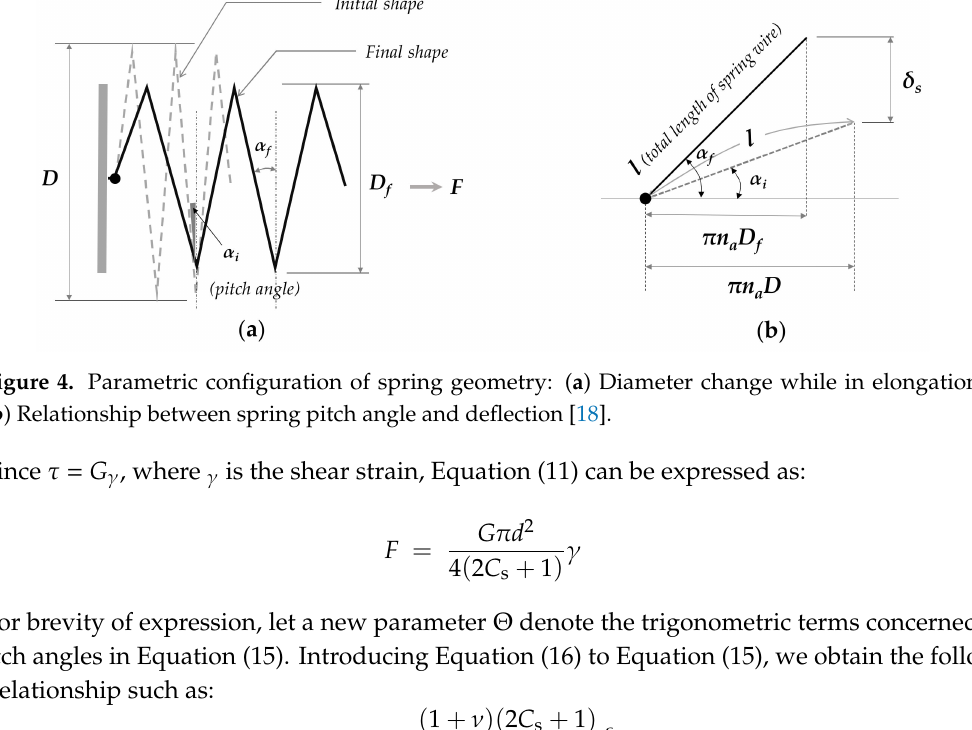
Figure 3. Schematic configuration of ( a ) SMA-bias actuation system and ( b ) MVF-temperature cycle (A: austenite, M: martensite).